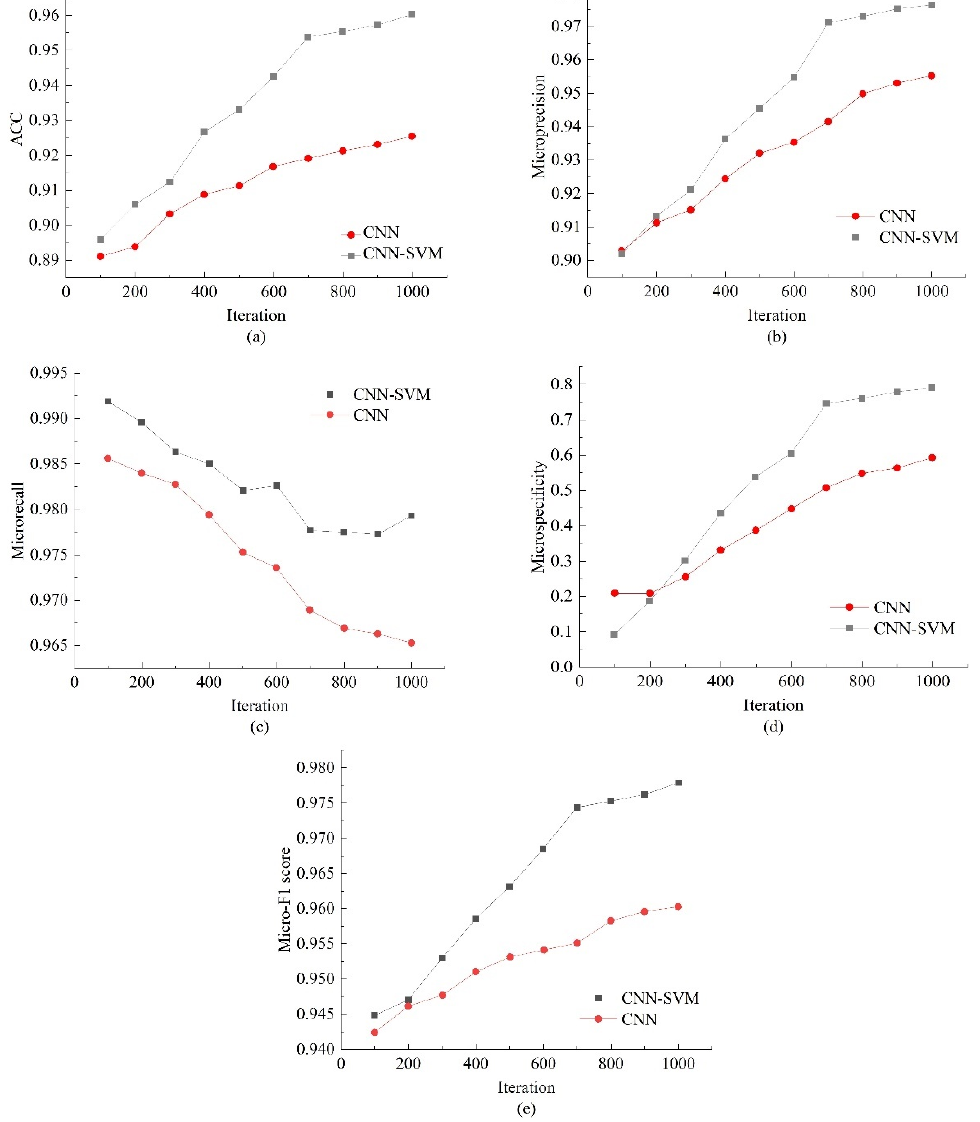
Figure 9. CNN ‐ SVM and CNN performance comparison plots. ( a ) CNN and CNN ‐ SVM accuracy Figure 9. CNN-SVM and CNN performance comparison plots. ( a ) CNN and CNN-SVM accuracy comparison. ( b ) CNN and CNN ‐ SVM micro ‐ precision comparison. ( c ) CNN and CNN ‐ SVM micro ‐ comparison. ( b ) CNN and CNN-SVM micro-precision comparison. ( c ) CNN and CNN-SVM micro- recall comparison. ( d ) CNN and CNN-SVM micro-specificity comparison. ( e ) CNN and CNN-SVM micro-F1 scores